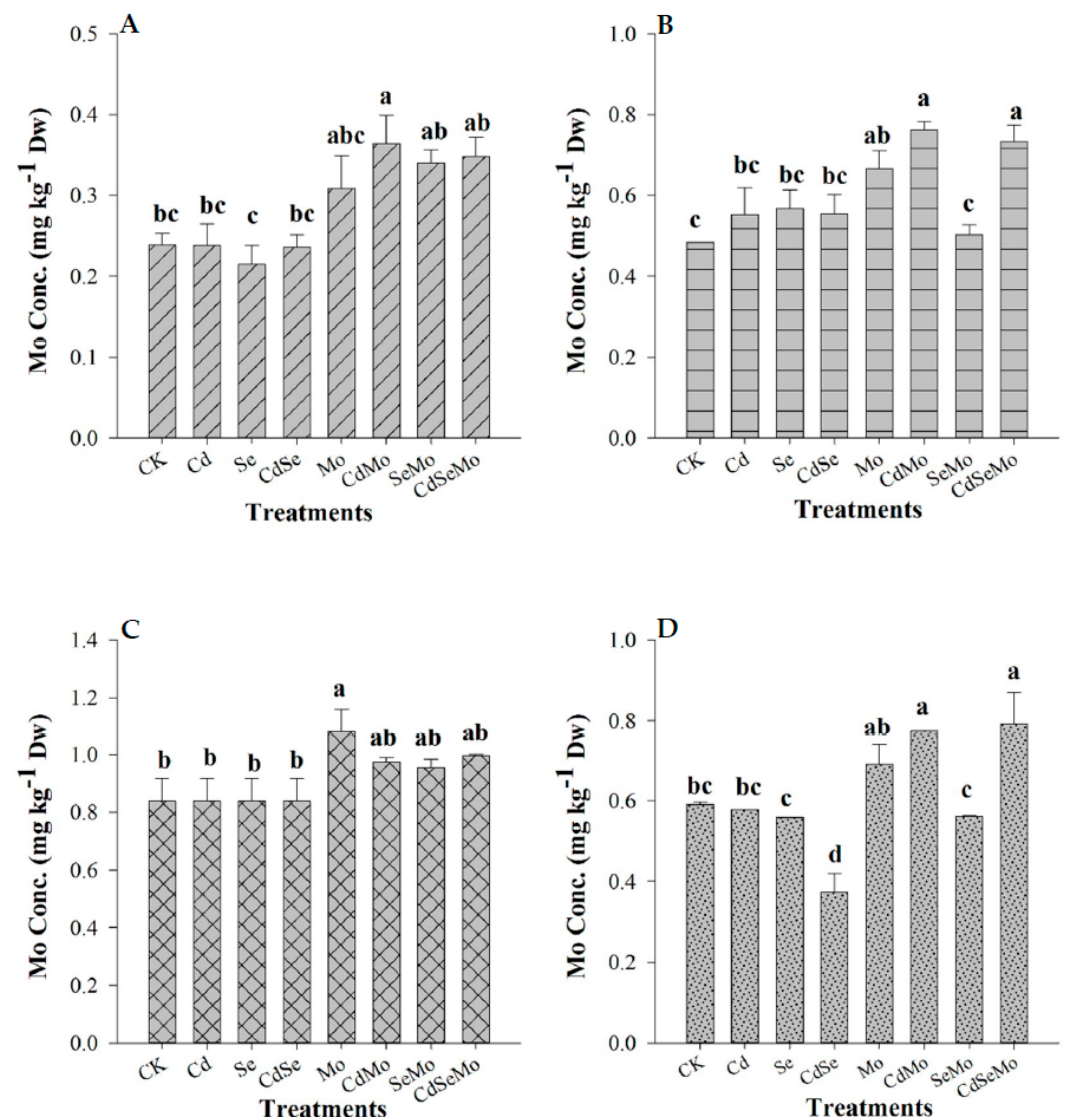
Figure 4. Concentrations of Mo in B. napus tissues under different treatment conditions. Mo content in root ( A ), stem ( B ), glume ( C ), and seed ( D ) of oilseed rape treated with foliar spray of (1 mg/L) Se and/or (0.3 mg/L) Mo in absence or presence of Cd stress (5 mg/kg). Bars indicate standard error ( n = 4). Different letters indicate significant differences at ( p < 0.05).